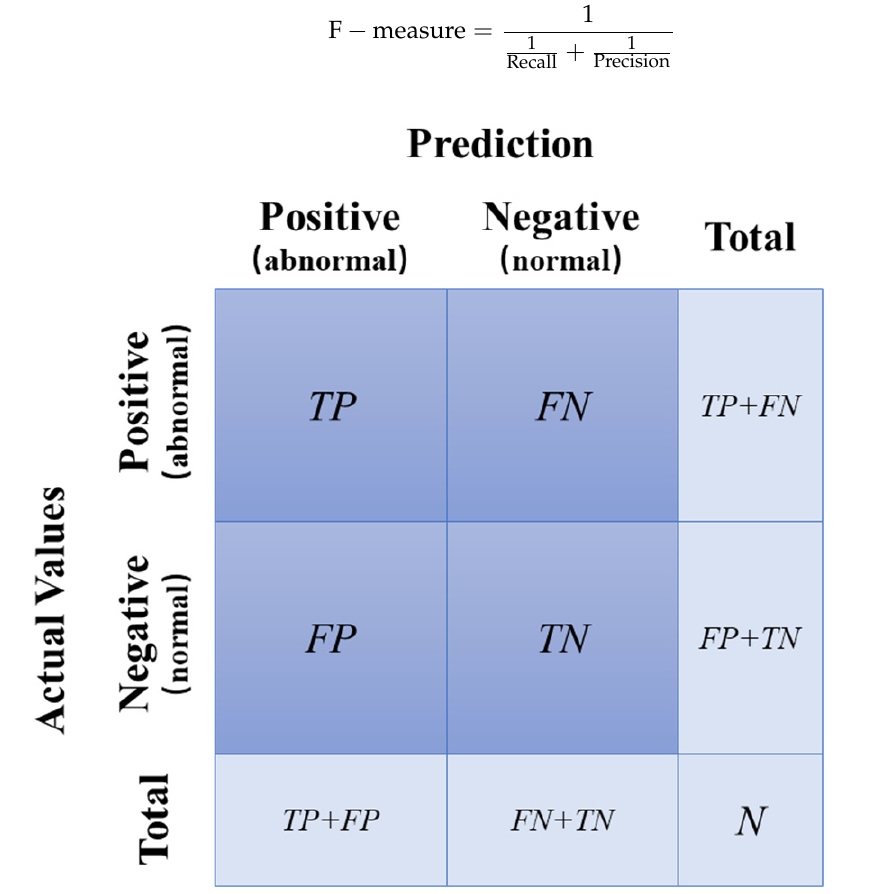
Figure 2. Confusion matrix of prediction.